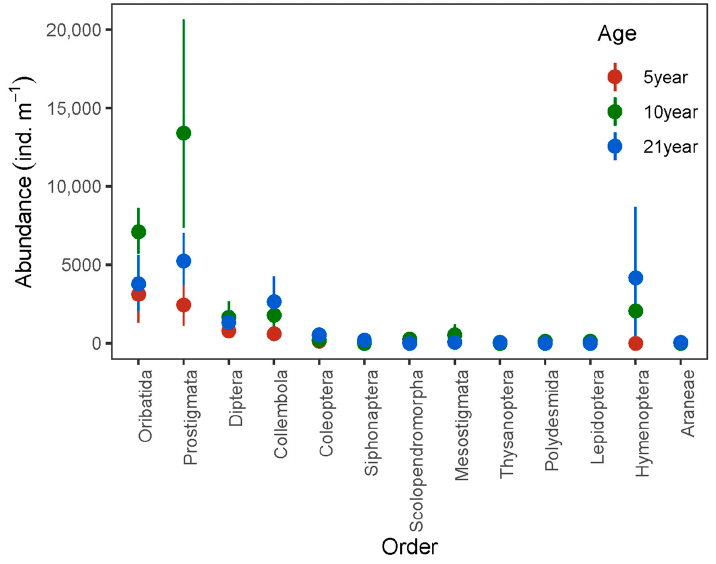
Figure 2. Rank-abundance of different arthropod orders. Filled circles are bootstrapped means, with 95% bootstrapped confidence intervals (error bars).